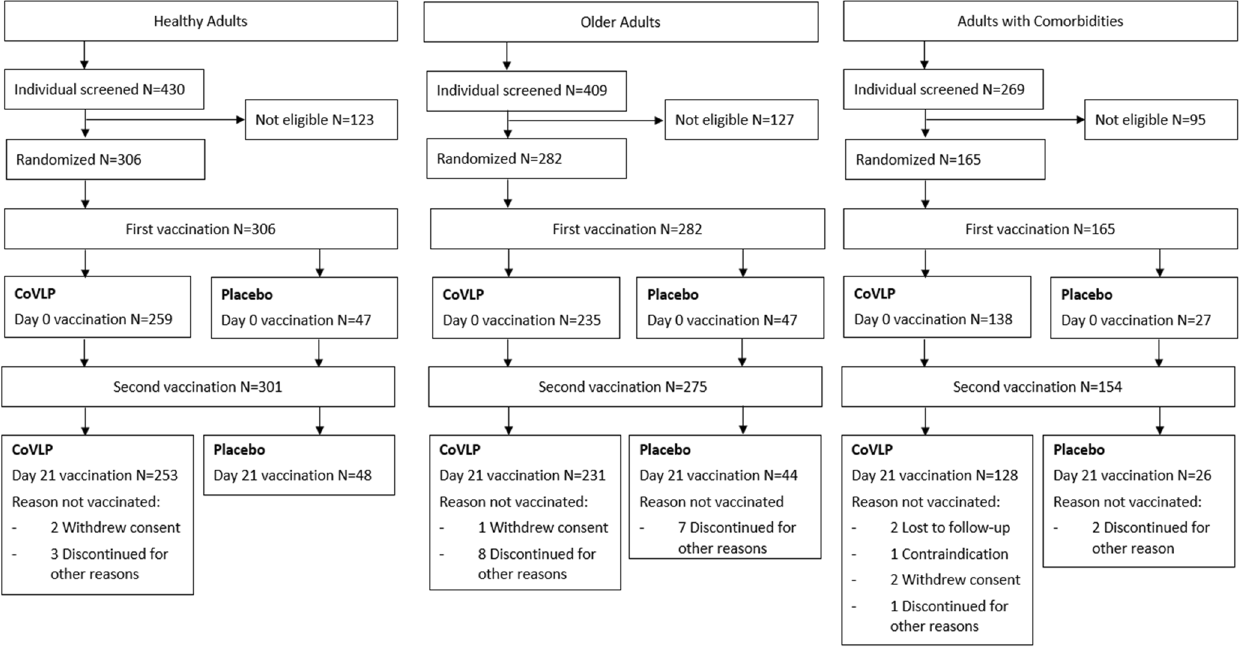
Fig. 1 Trial pro fi le – subject disposition. Enrollment and follow-up of study participants vaccinated with CoVLP with AS03 or placebo after the fi rst and second dose administration. For both Healthy Adults and Older Adults, one subject was mis-dosed for the second dose administration and received a placebo in error. One individual in the Adults with Comorbidities group that was initially seropositive at D0 did not receive an injection. For more details of subject disposition, see Table